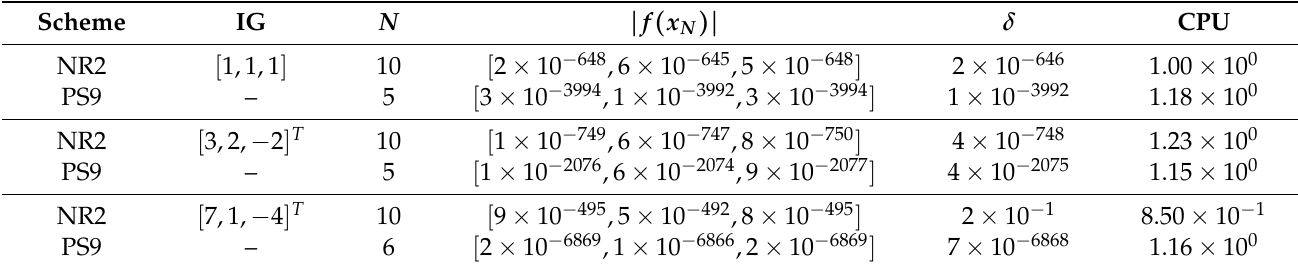
Table 12. Numerical results for problem 7 with different initial